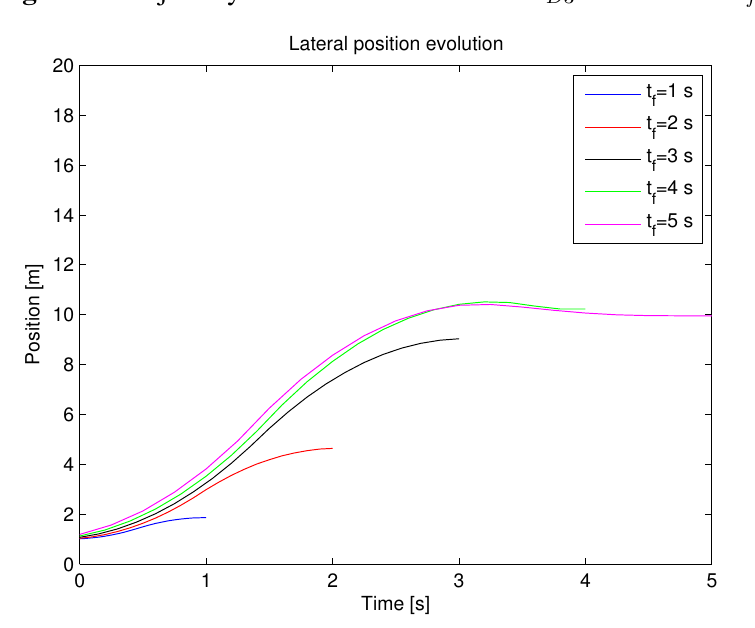
Figure 8. Trajectory evolution of functional J